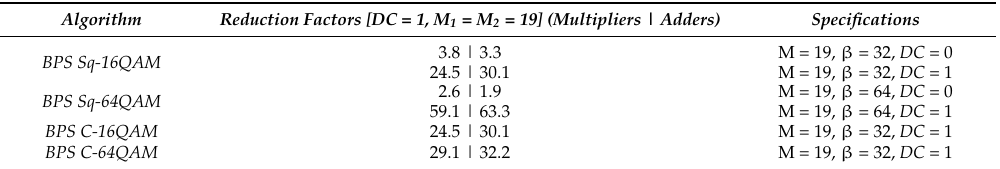
Table 2. Computational complexity reduction factors relative to two-stage n-PSK partitioning algorithm employing sub-optimal decision boundaries in the symbol decision circuit module. Algorithm